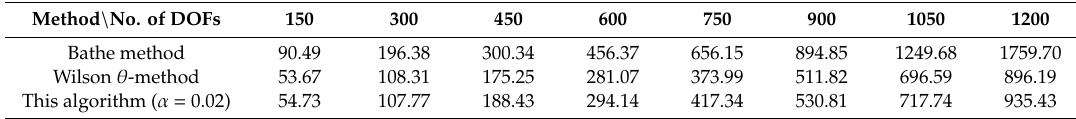
Table 4. Computational times of different methods (s).